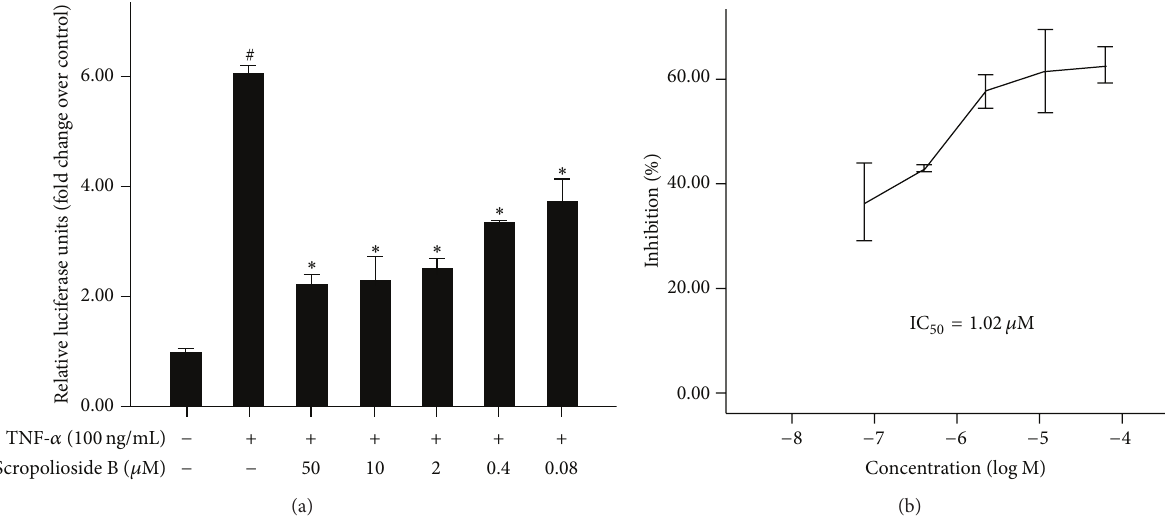
Figure2:ScropoliosideBinhibitedTNF- 𝛼 -inducedNF- 𝜅 Bactivation.Cellswerepreincubatedfor1hourwithdifferentdosesofscropolioside B and then stimulated with 1 𝜇 g/mL TNF- 𝛼 for 16 hours. The results shown are representative of 3 separate experiments. Data are expressed as means ± SD. # 𝑃 < 0.05 versus the control, ∗ 𝑃 < 0.05 versus the TNF- 𝛼 (a). IC 50 values of 1.02 𝜇 mol/L (b).